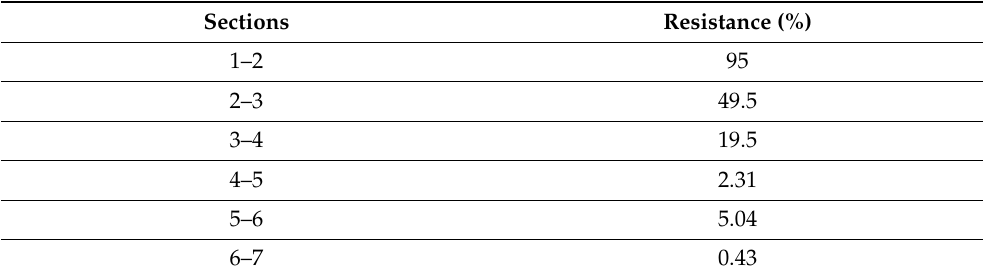
Table 1. The resistance to airflow in the different regions of nasal cavity (7 CT sections), expressed as the percentage difference in pressures between the individual sections (%).